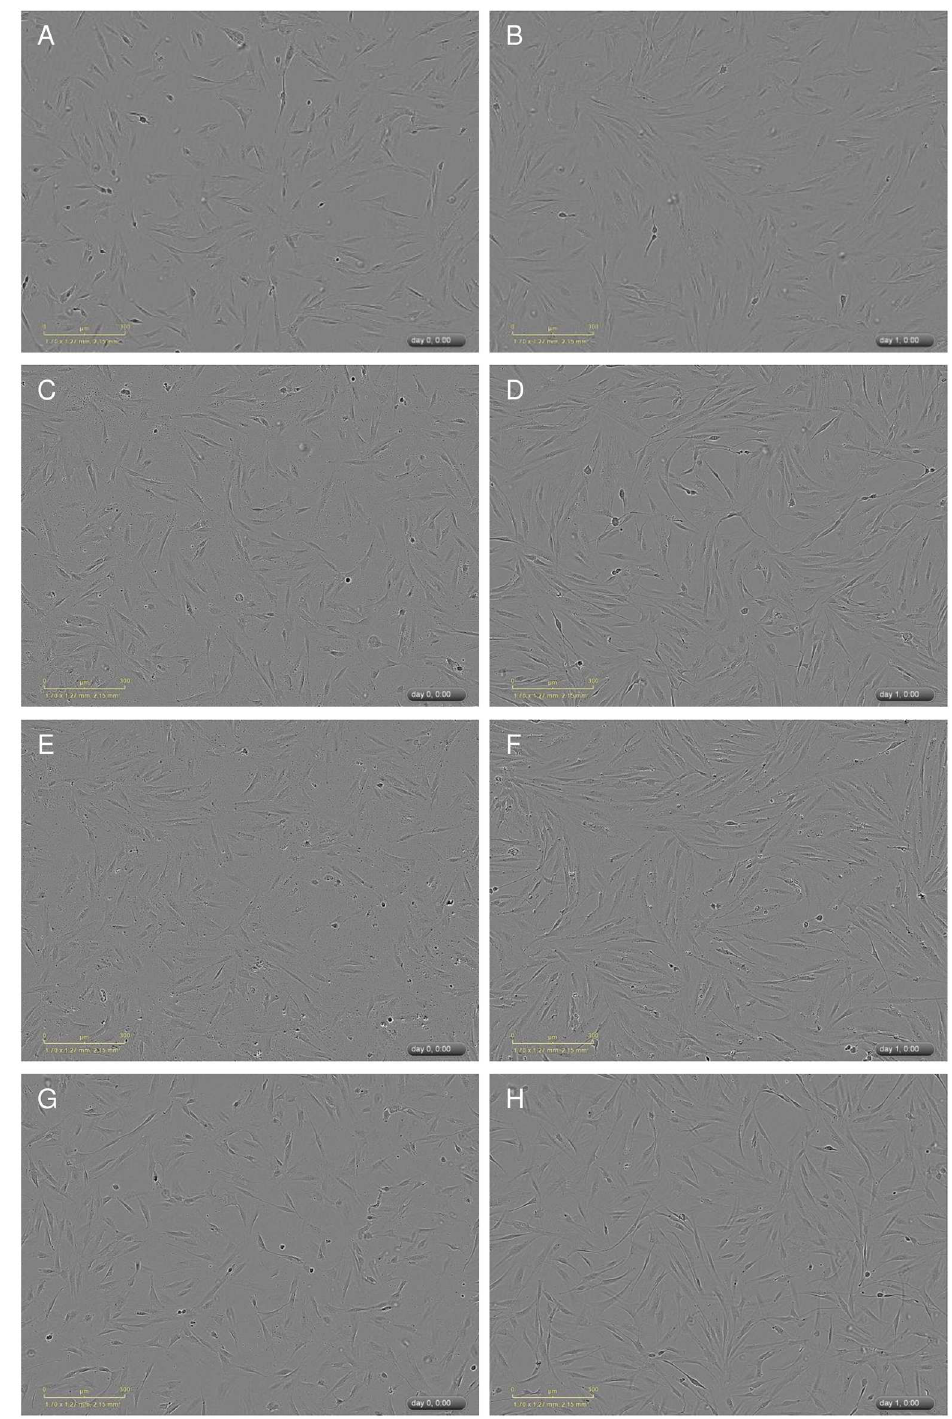
Fig 1. Cell morphology was not influenced by the used Biodentine ® suspensions. Cell morphology was monitored with an incubatormicroscopeunit. Shown are exemplary pictures of the cell morphology immediately after applicationof the Biodentine ® suspensions or fresh control medium (A,C,E,G) and after 24h (B,D,F,H). Morphological changes could not be observedbetweenthe control (A,B) and the Biodentine ® suspensions of low (C,D), moderate (E,F) or high (G,H)